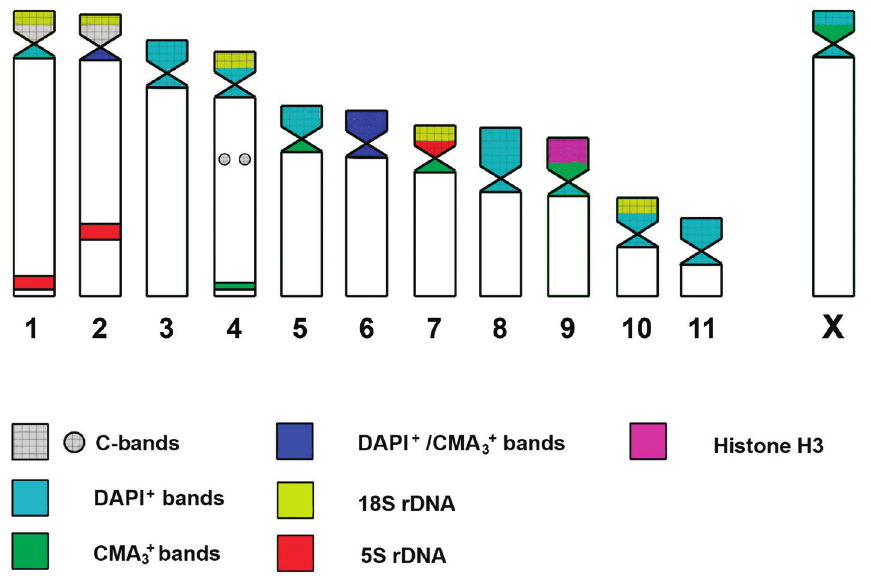
Figure 3. Idiogram showing the mapping of different sequences studied in Abracris flavolineata from the Iguaçu National